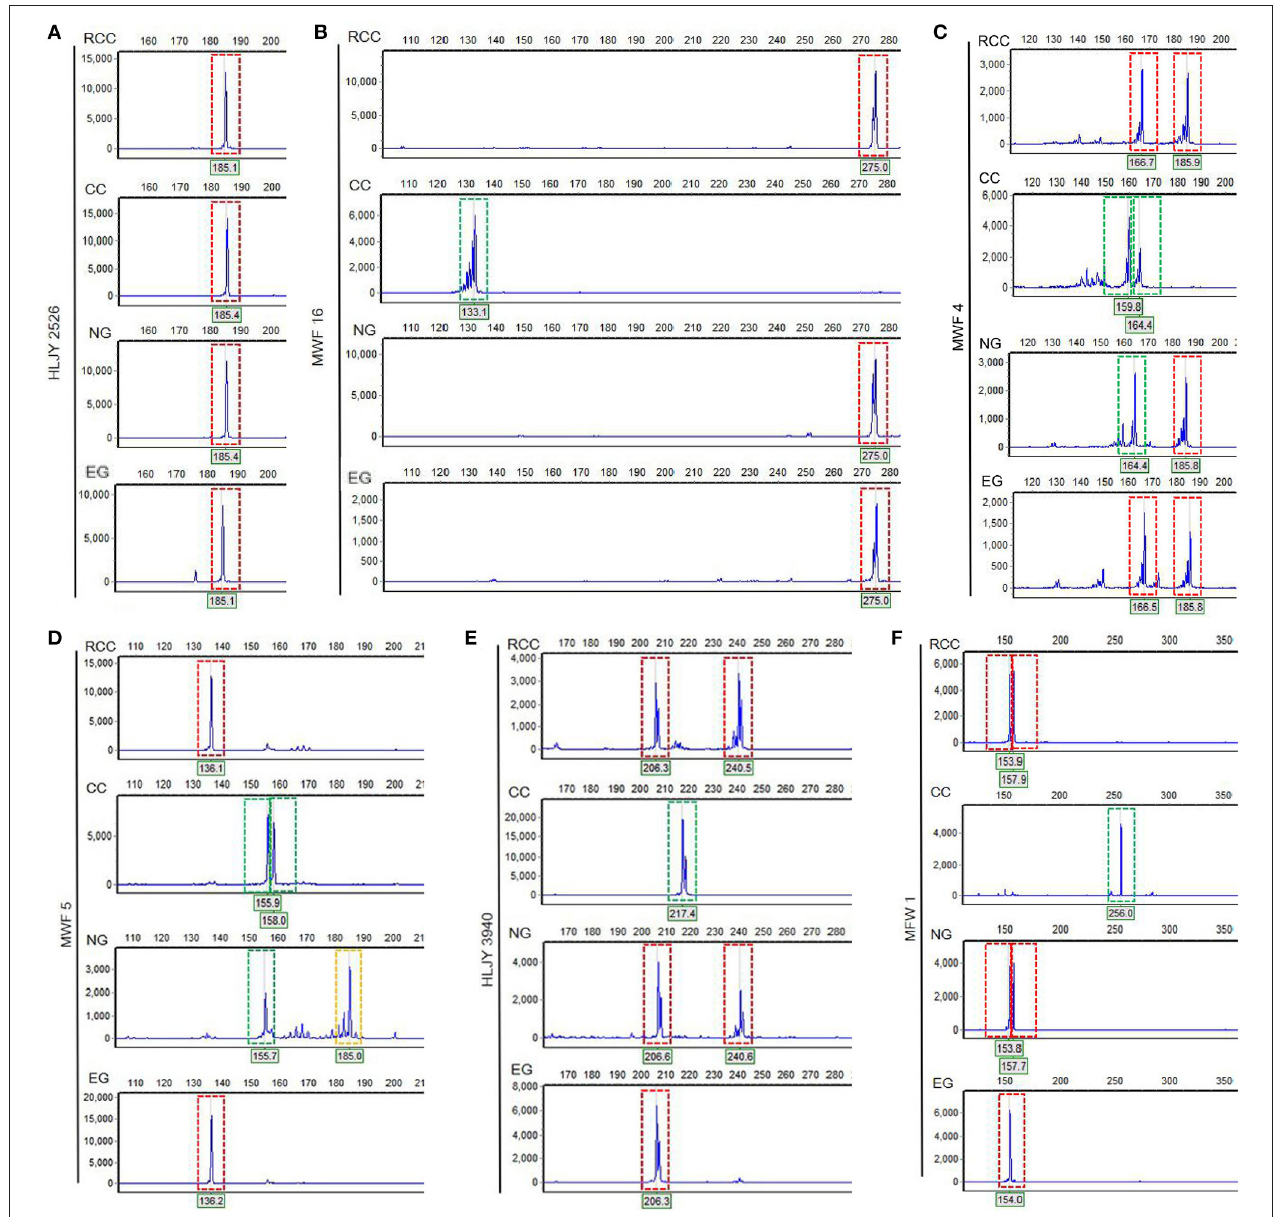
FIGURE 3 | Electropherograms showing allelic peaks at six loci across the four fish lines. (A) HLJY 2526 locus. (B) MWF 16 locus. (C) MWF 4 locus. (D) MWF 5 locus. (E) HLJY 3940 locus. (F) MFW 1 locus. Peaks boxed in red are unique to the crucian carp; peaks boxed in green are unique to the common carp; peaks boxed in yellow are unique to the natural goldfish. The x -axes show the size of each segment, and the y -axes indicate the strength of the corresponding signal.